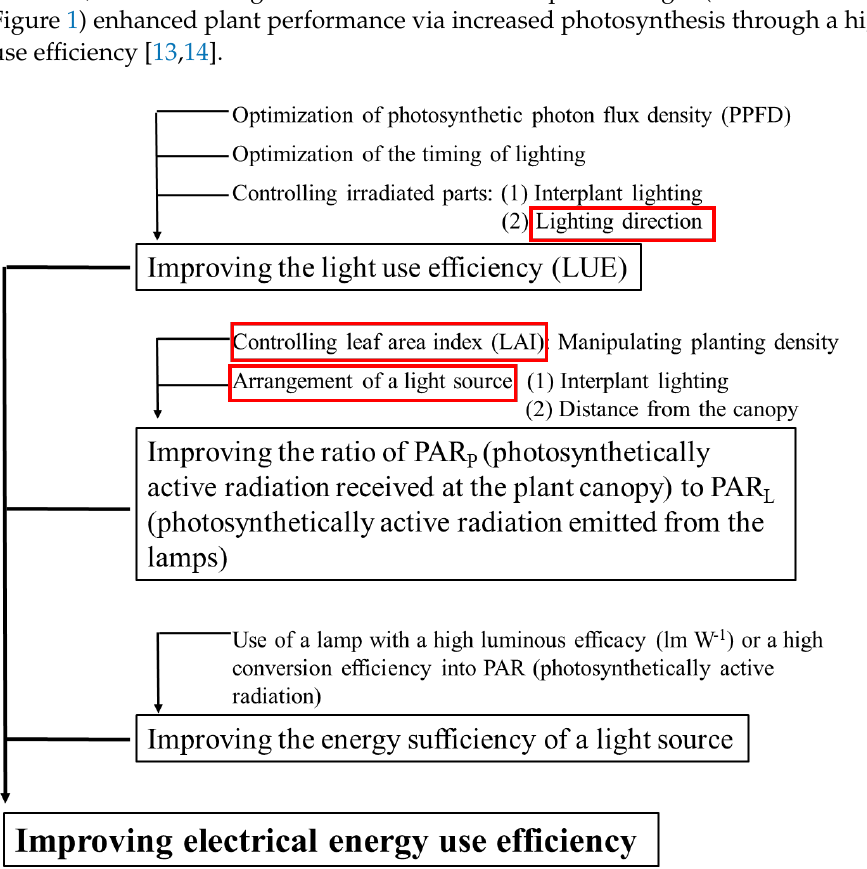
Figure 1. Factors affecting the electrical energy use